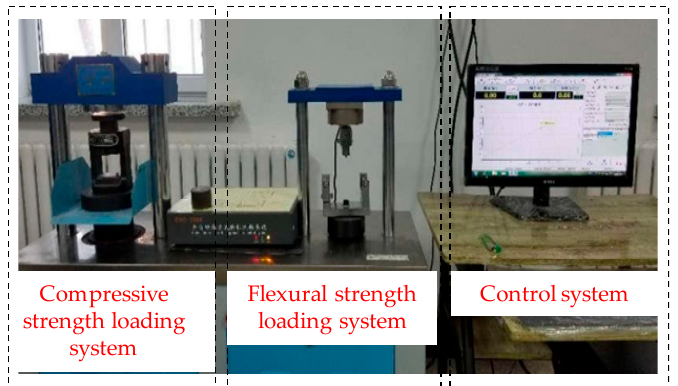
Figure 2. The specific experimental device.